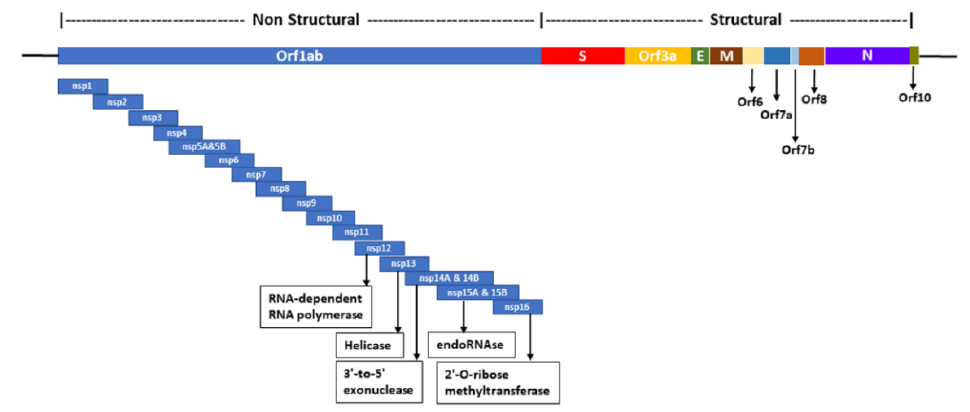
Figure 1. Genomic structure of SARS-CoV-2. The entire genome is classified as nonstructural and structural regions that produce multiple open reading frames (ORFs).